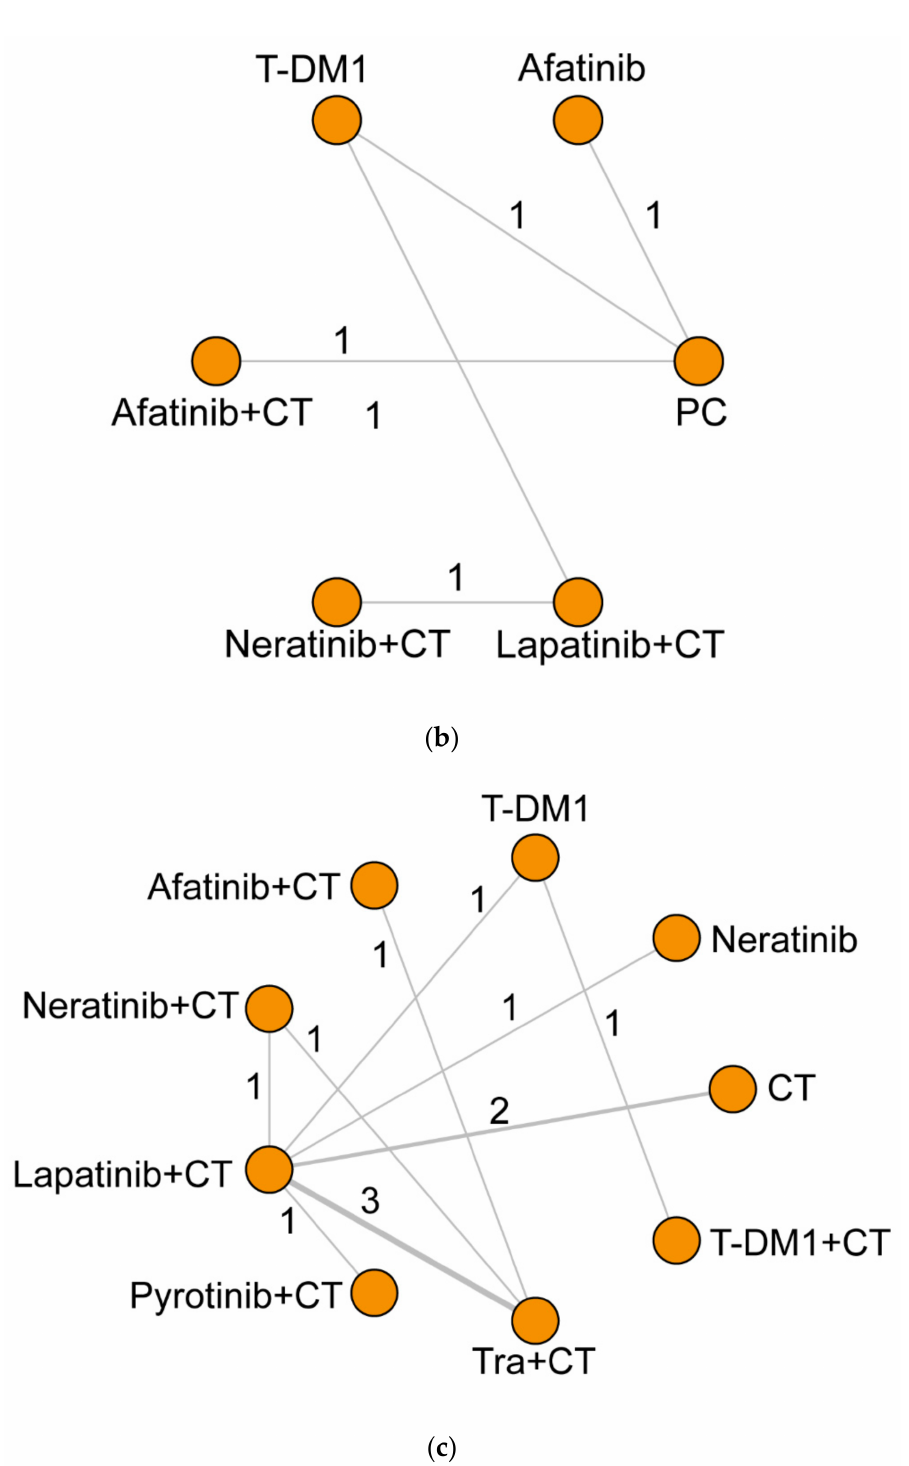
Figure 3. Network plots of PFS ( a ), OS ( b ) and the recurrent rate of CNS ( c ). Every node represents one kind of intervention while the lines are related to direct comparisons. Abbreviations: CNS, central nervous system; T-DM1, trastuzumab emtansine; T-DXd, trastuzumab deruxtecan; PC, physician’s choice; CT, chemotherapy; Tra,